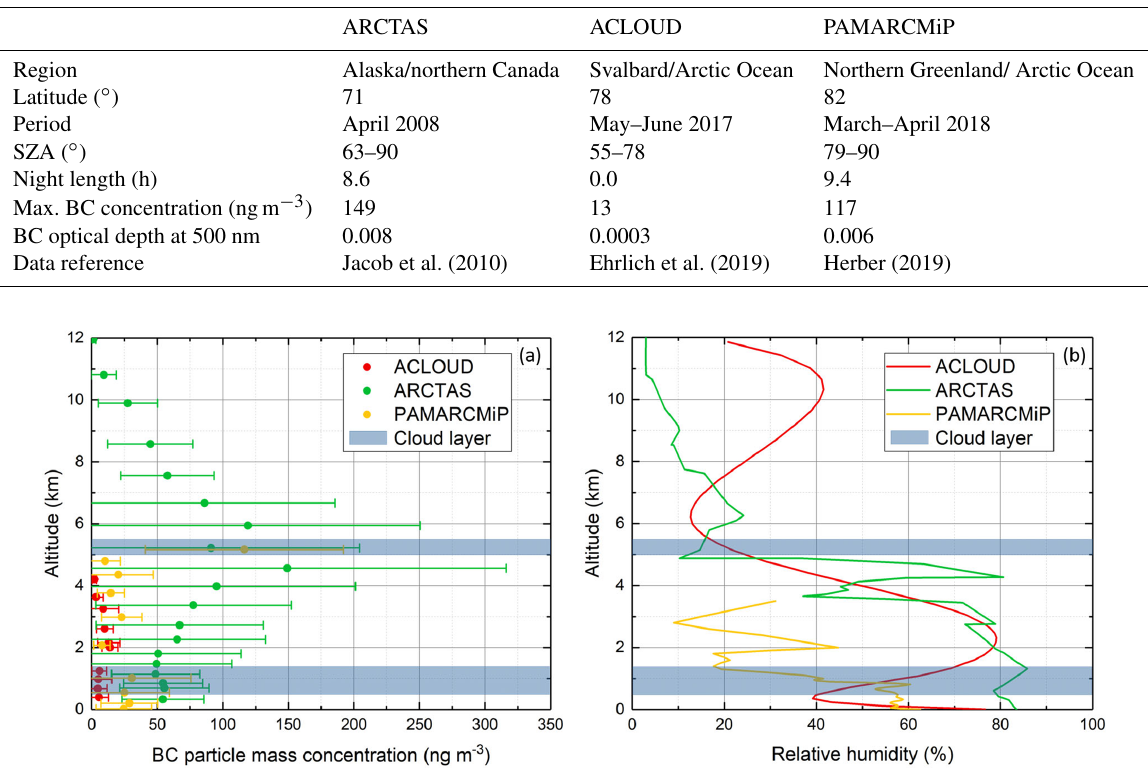
Figure 1. Mean profiles of atmospheric BC particle mass concentration (a) and relative humidity (b) averaged for each of the three campaigns (ACLOUD, ARCTAS, and PAMARCMiP) as used for the radiative transfer simulations. Horizontal bars indicate the standard deviation. The positions of the two implemented cloud layers (blue shaded area) are